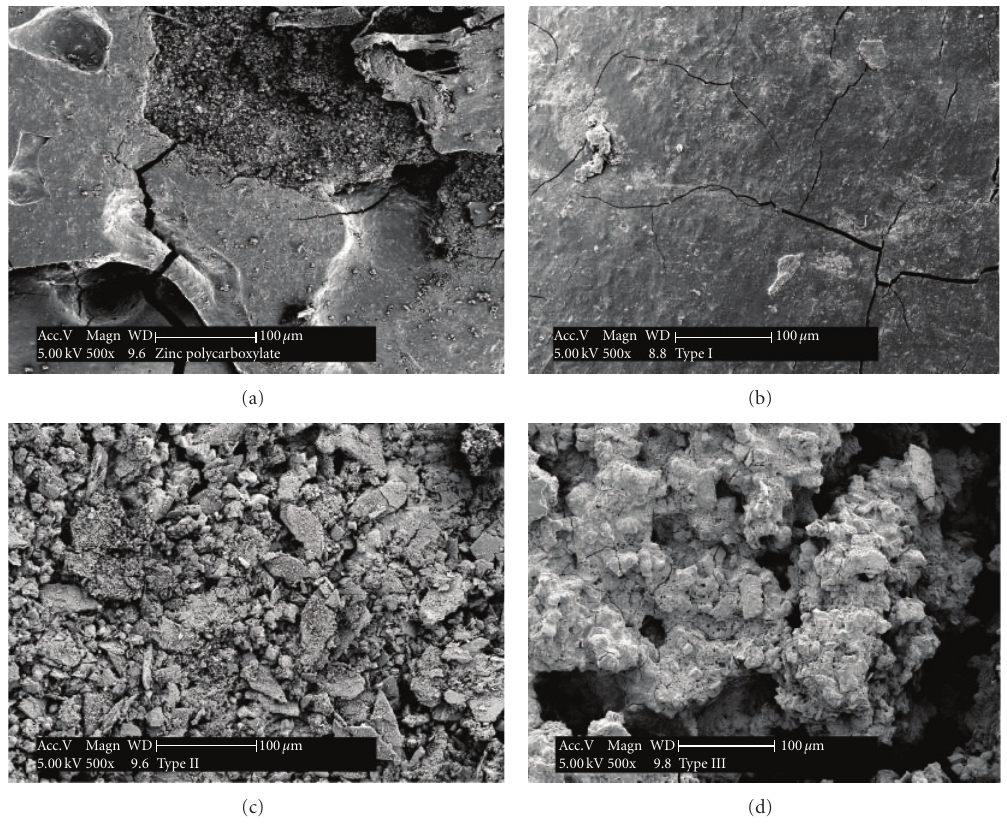
Figure 6: SEM microphotograph of the longitudinal top surface of the four types of cements. (a) Zinc polycarboxylate cement; (b) Type I; (c) Type II; (d) Type III after